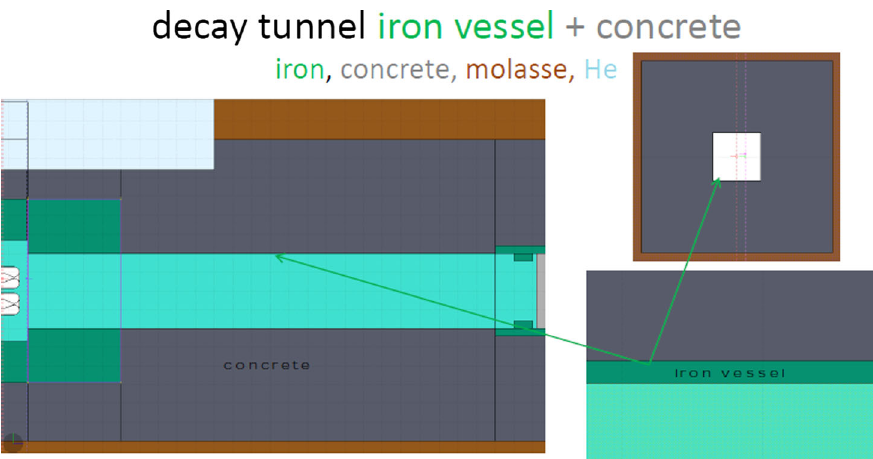
FIG. 27. Decay tunnel